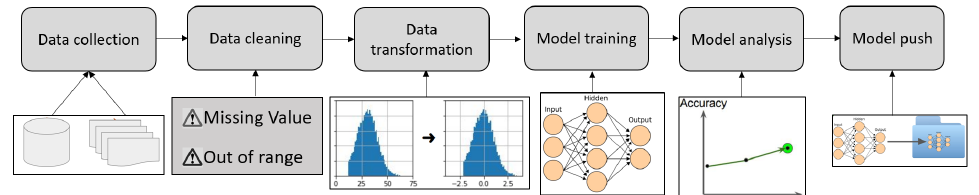
Figure 5. Pipeline of applying machine learning in